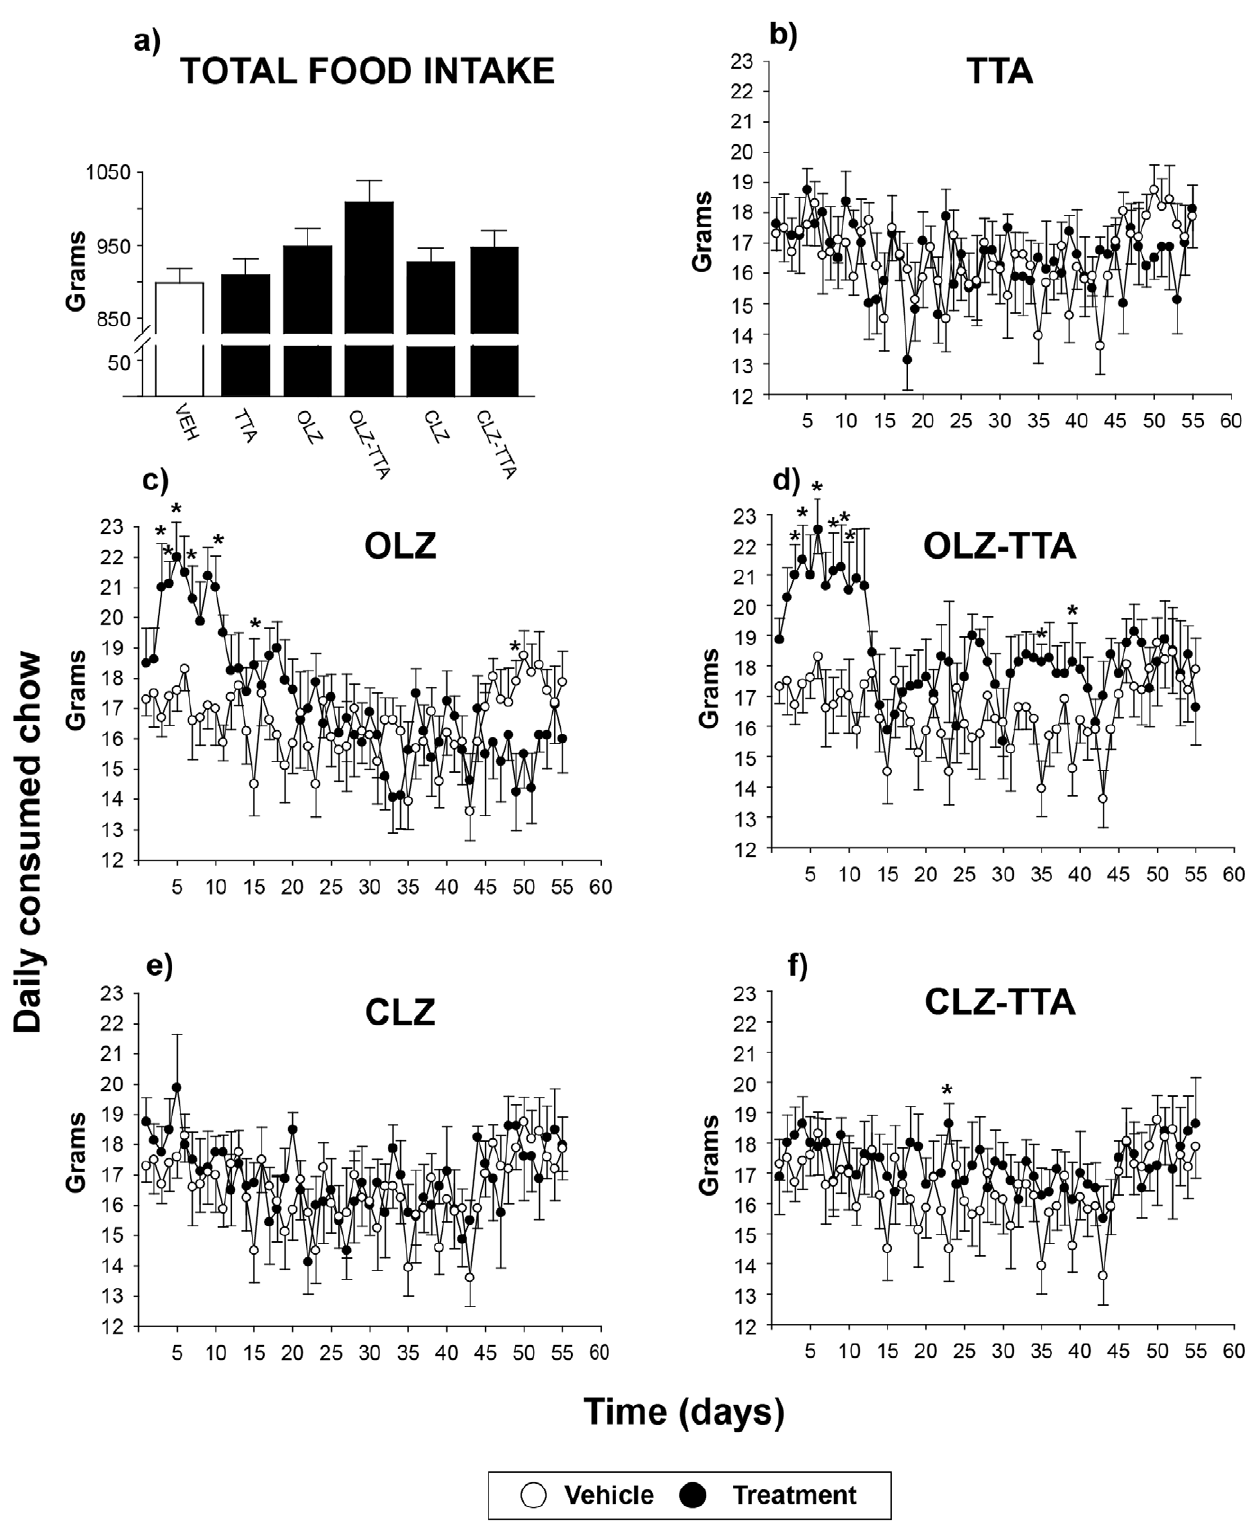
Figure 2. Daily food intake during 8 weeks of treatment with antipsychotics and TTA. Total food intake during the entire treatment period of 8 weeks (a) and daily food intake during chronic treatment with vehicle (open circles), antipsychotic monotherapy, TTA, or antipsychotics in combination with TTA (filled circles; b-f). Data are given as mean 6 SEM. * P # 0.05 vs vehicle (Dunnett’s post hoc test for daily food intake). TTA: tetradecylthioacetic acid, OLZ: olanzapine, CLZ: clozapine.